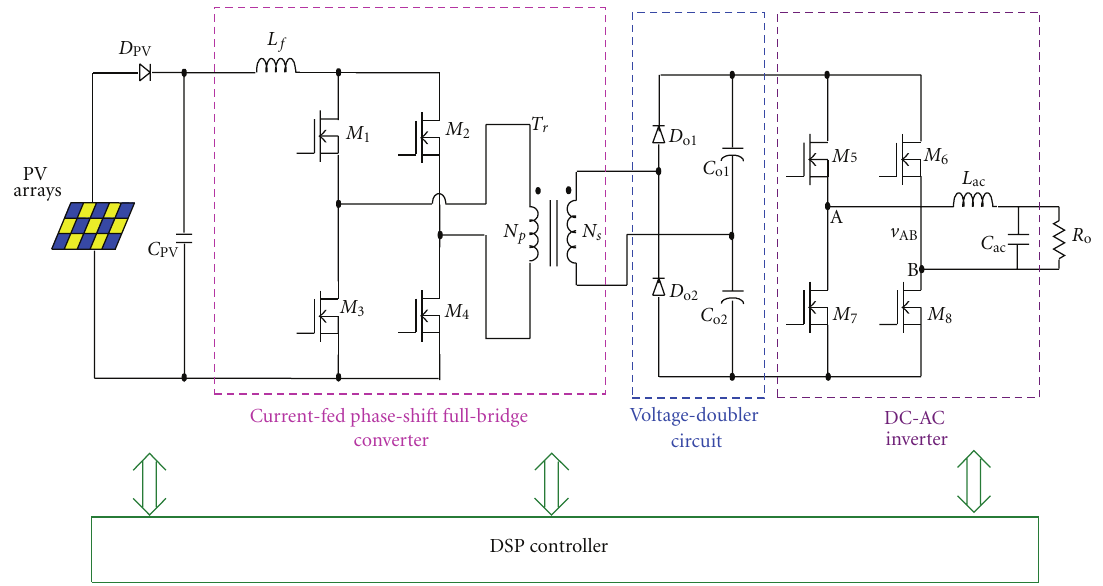
Figure 1: Circuit structure of the proposed PV power system for high step-up applications.